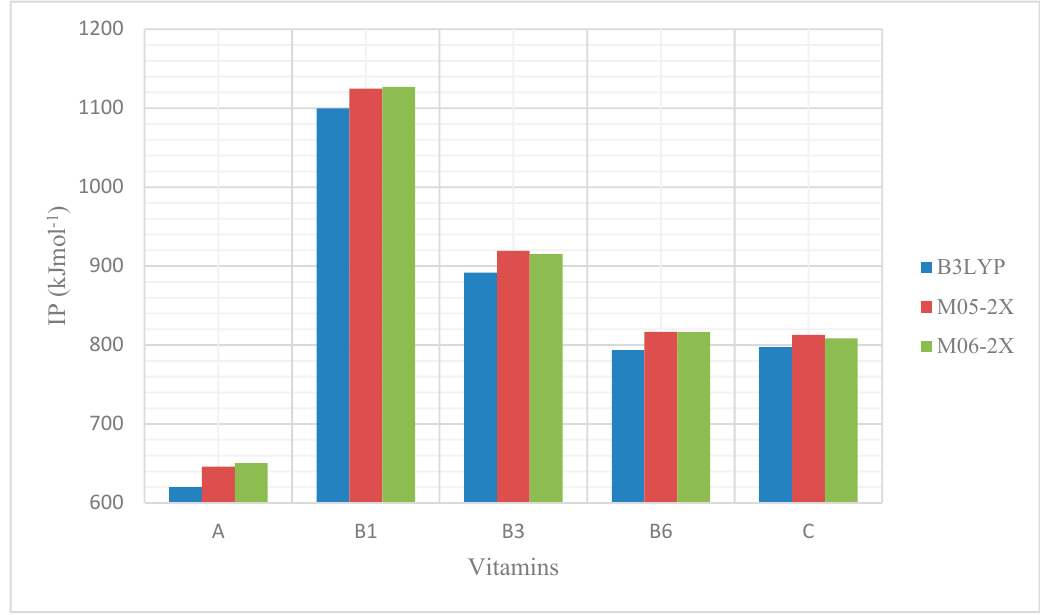
Figure 4. Comparison of ionization potentials (IP) of the dietary vitamins.